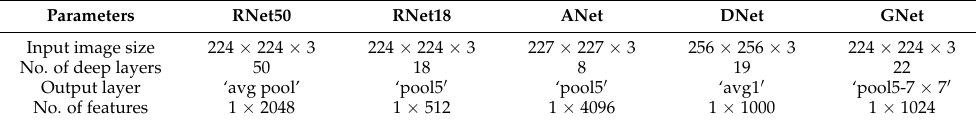
Table 2. Architecture details of the various deep-learning methods used in this work.